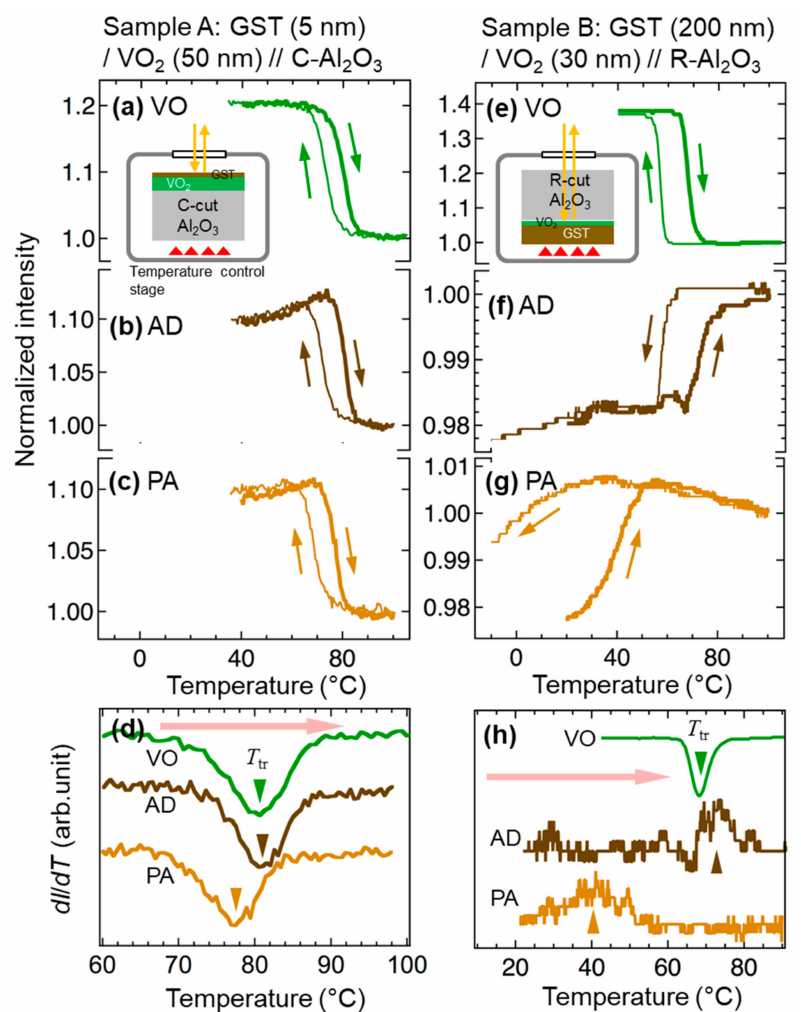
Figure 3. Temperature dependence of optical reflection intensity from Sample A ( a – c ) and Sample B ( e – g ) in steps VO ( a , e ), AD ( b , f ), and PA ( c , g ) during heating (thick lines) and cooling (thin lines) runs. The intensity is normalized at 100 ◦ C. The incident light was shone upon the film side (Sample A) or from substrate side (Sample B), as illustrated in insets of ( a ) and ( e ). ( d , h ) Temperature-di ff erential profiles of reflection intensity ( dI / dT ) in the heating runs for Samples A and B, respectively, at the three steps. The triangle symbols indicate the peak / valley